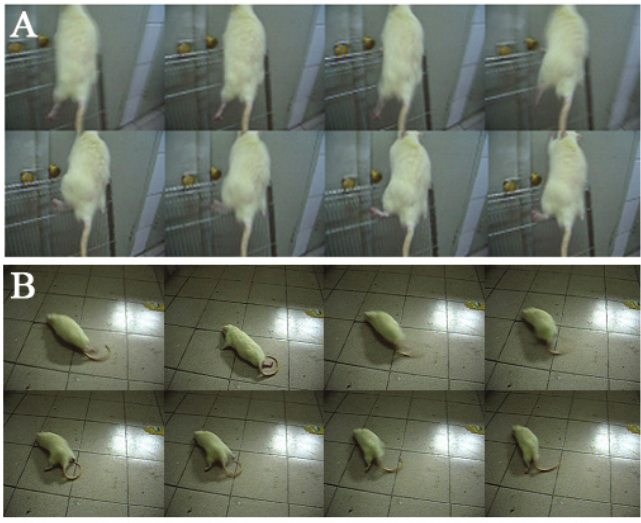
FIGURE 3 – A. Walking test after paraplegia. B. Ascending test after